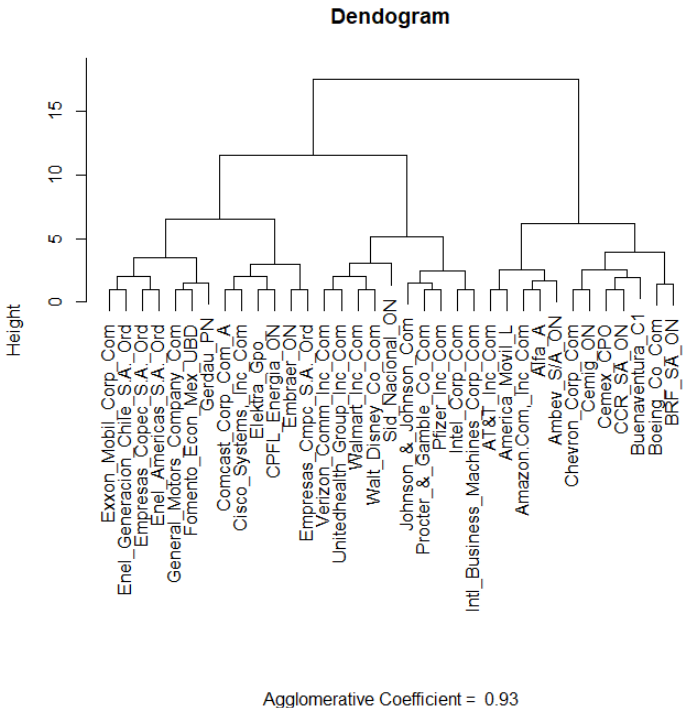
Figure 2. Dendrogram for the companies selected. Source: Own elaboration with R-project and “cluster” package.